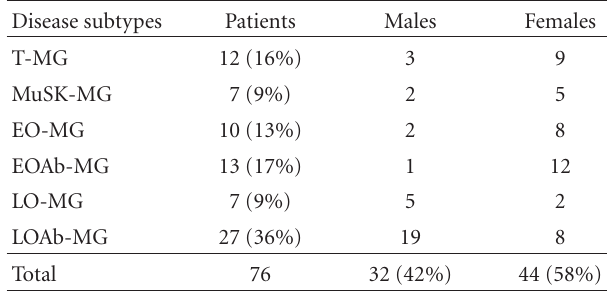
Table 1: Demographic and clinical features of the MG patient pop-